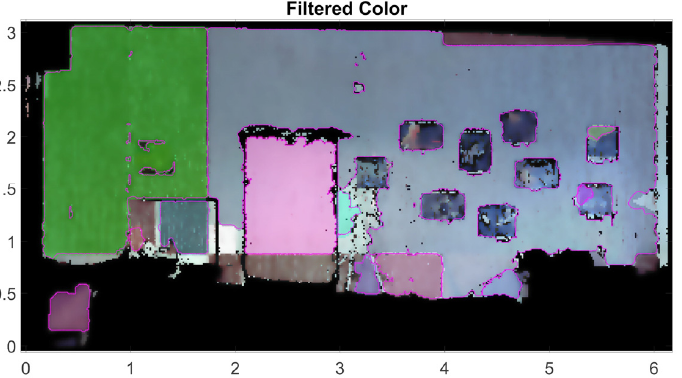
Figure 10. Final segmentation curves. Transparent colors represent the segments of the image. Postprocessing